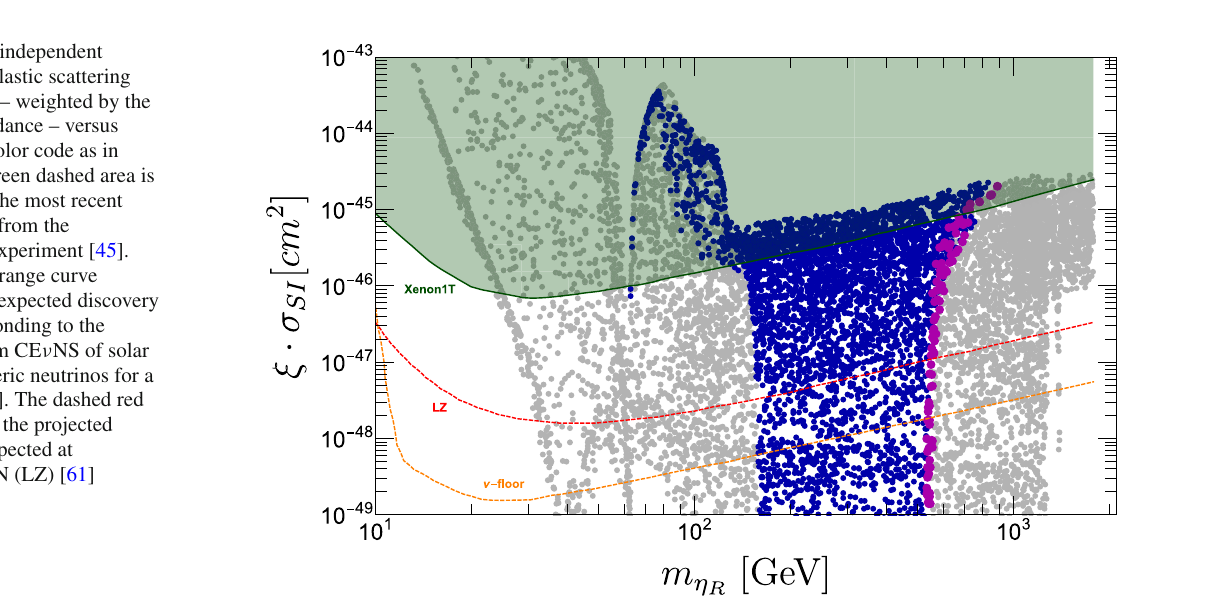
ξ = (cid:21) η R versus the η R mass. We use the same color (cid:21) CDM , Planck codeasinFig.2.Theplaingreenlineanddashedareaindicate the current most stringent limit from XENON1T [45].